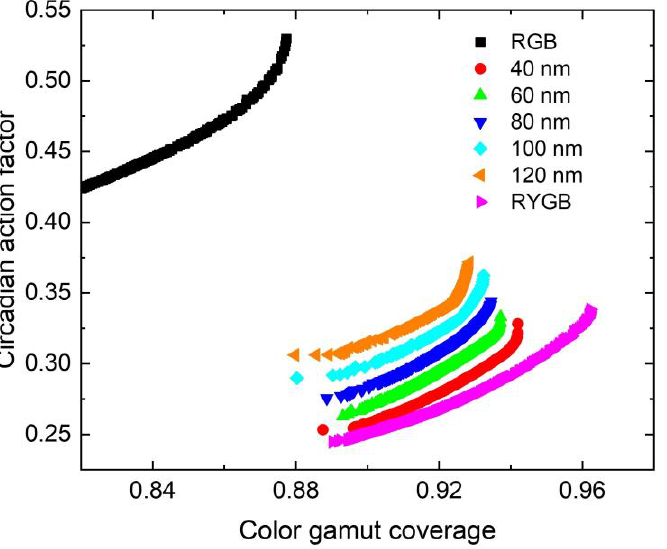
Figure 6. Pareto front of red, yellow, green, and blue (RYGB)-type micro-LED displays. In the plot, RYGB denotes the case with yellow micro-LED chips.